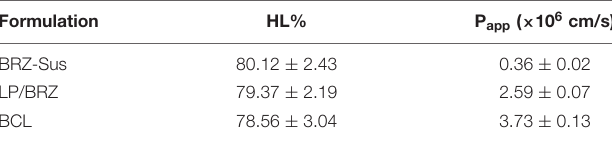
TABLE 1 | Corneal hydration level and P app of different formulations containing brinzolamide. Data are expressed as mean ± SD ( n = 3). Formulation